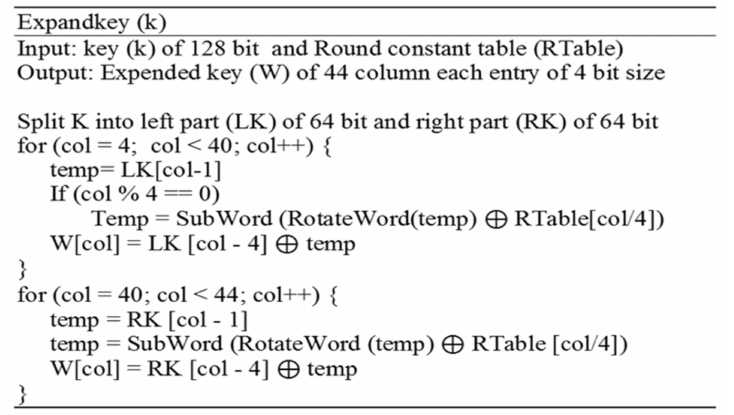
Figure 3. Expand